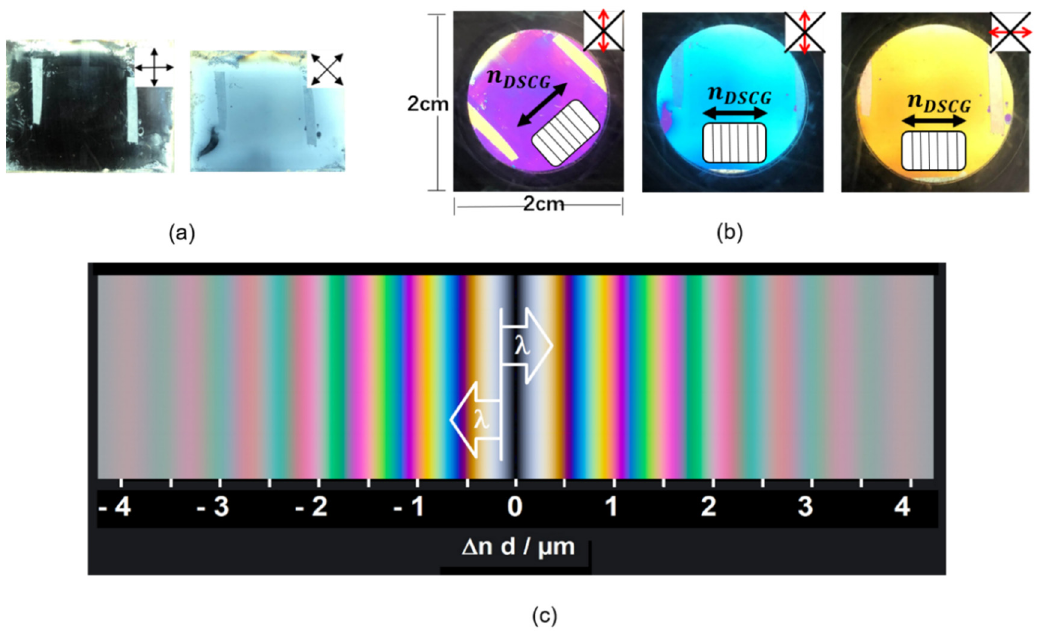
Figure 3. Experimental results indicating uniform alignment and orientational order in chromonic liquid crystal (LC) samples. ( a , b ) Polarized optical images of a nanocomposite containing DSCG and DNA nanostructures in an antiparallel rubbed polyimide (PI) cell, ( a ) between crossed polarizers (upper right corner: polarization planes) and ( b ) together with the a λ -retardation plate (slow axis marked red) between crossed polarizers (marked dark). ( c ) Michel–Levy chart of interference colors from birefringent samples.